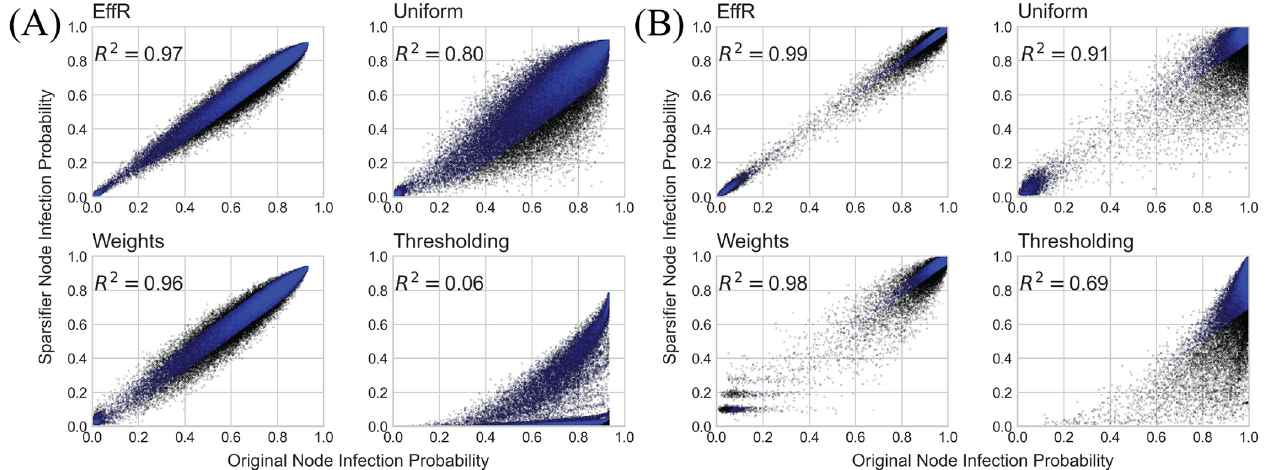
Fig 2. Sparsification of the U.S. mobility network: preserving infection probabilities. Scatterplots of infection probabilities for localized (A) and dispersed (B) initial conditions for four sparsification methods: effective resistance, uniform sampling, weight-based sampling, and simple thresholding. For each sampling method we chose 0.1 m edges of the original network, and we set the threshold to retain the 10% highest-weighted edges. Each dot represents a node in the network. The horizontal and vertical axes give the probability that node becomes infected using the original and sparse network respectively, based on 1000 independent runs of the SIR model. Dots close to the diagonal are those for which sparsification preserves this probability, and the blue dots represent the 90% of nodes closest to the diagonal. While weight-based sampling achieves a similar R 2 , it is not as good at preserving infection probabilities for low- probability nodes, especially for dispersed initial conditions. Effective resistance preserves the infection probability for both low- and high-probability nodes.